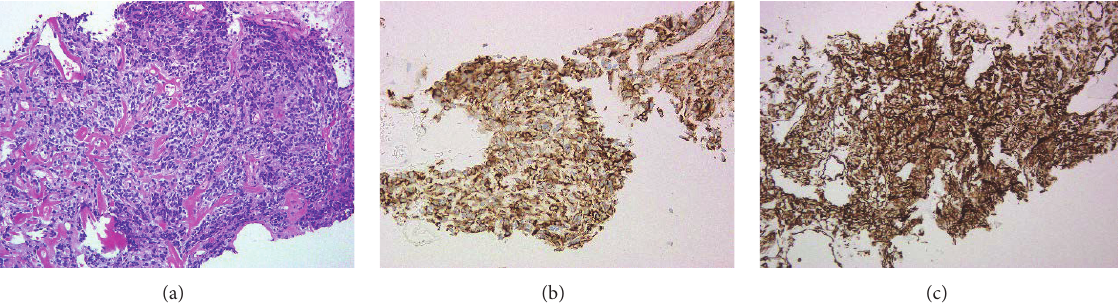
Figure 3: Microscopic findings of prostatic biopsy. (a) HE staining; (b) AE1/AE3; (c) vimentin (original magnification ×